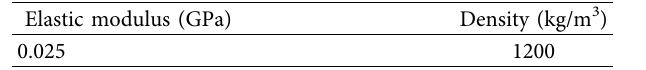
Figure 7: Designed PSPS with four cells (unit: mm). Table 1: Parameters of rubber.